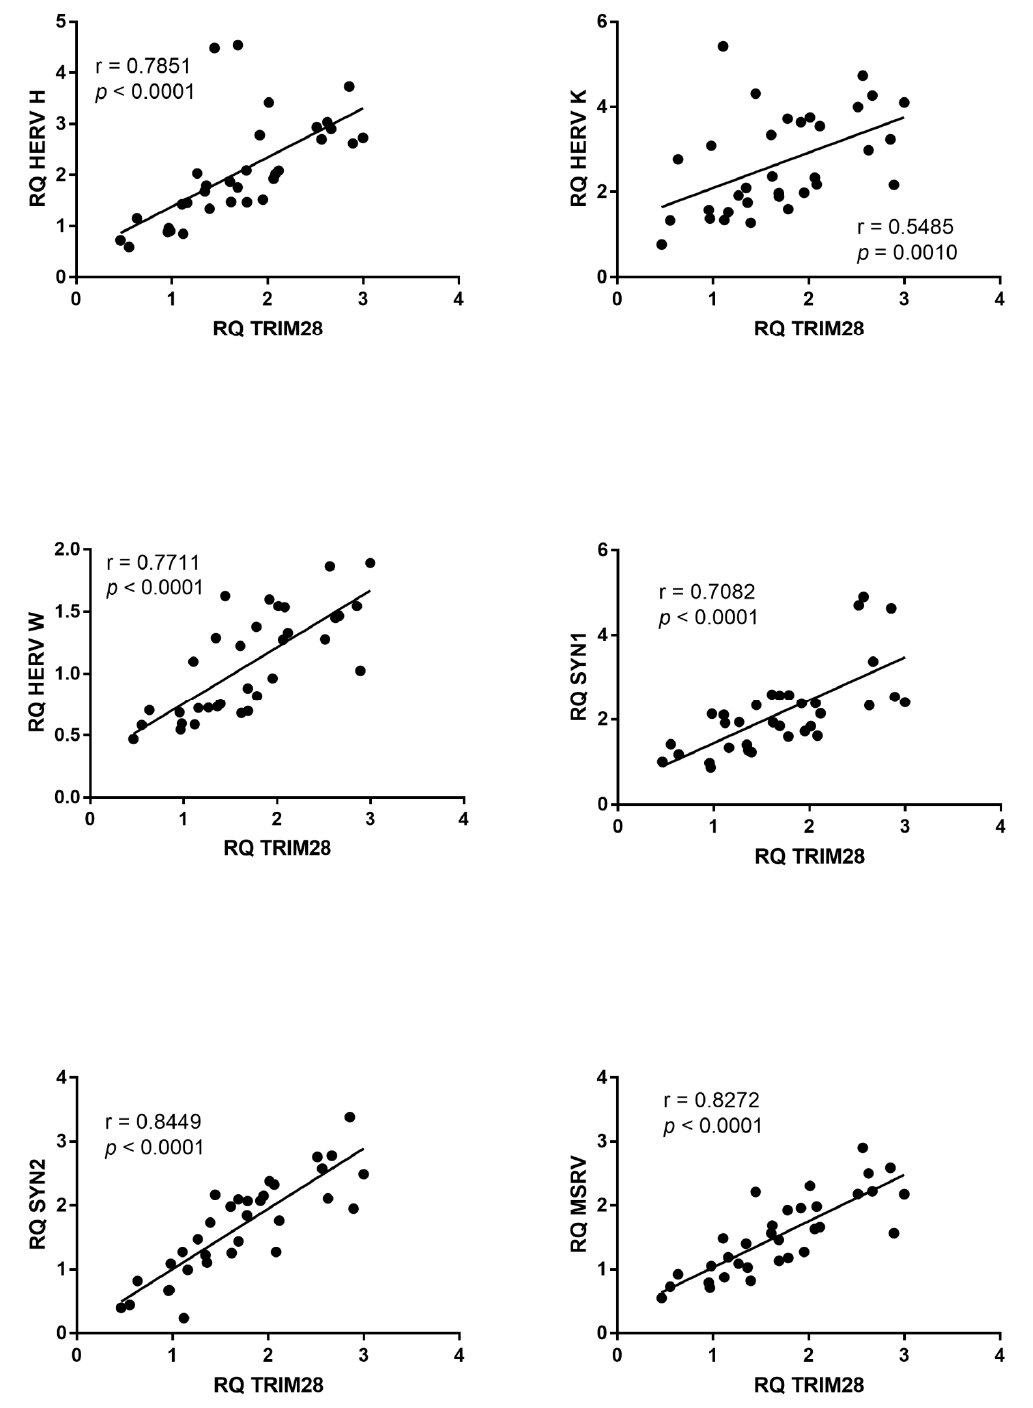
Figure 4. Correlations between transcription levels of TRIM28 and HERV sequences in whole blood from 33 children with ASD. RQ: relative quantification. Circles show the mean of three individual measurements. Line: linear regression line. Statistical analysis: Spearman correlation test.